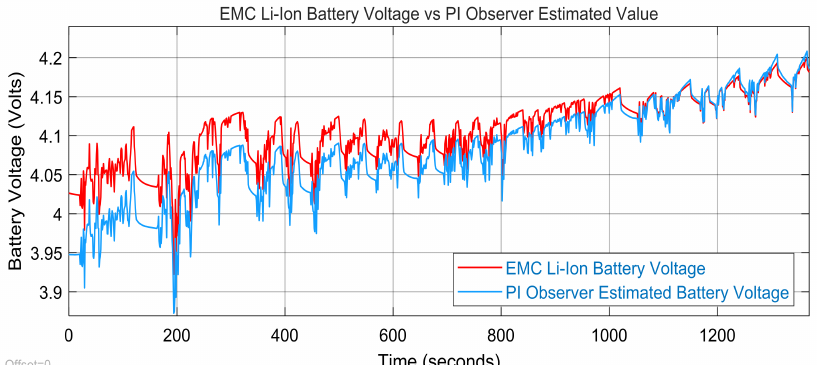
Figure 38. The robustness of 2RC EMC Li-Ion battery PIO estimator, to simultaneous change in SOC initial value and the measurement output white noise level of zero mean and standard deviation σ = 0.001.